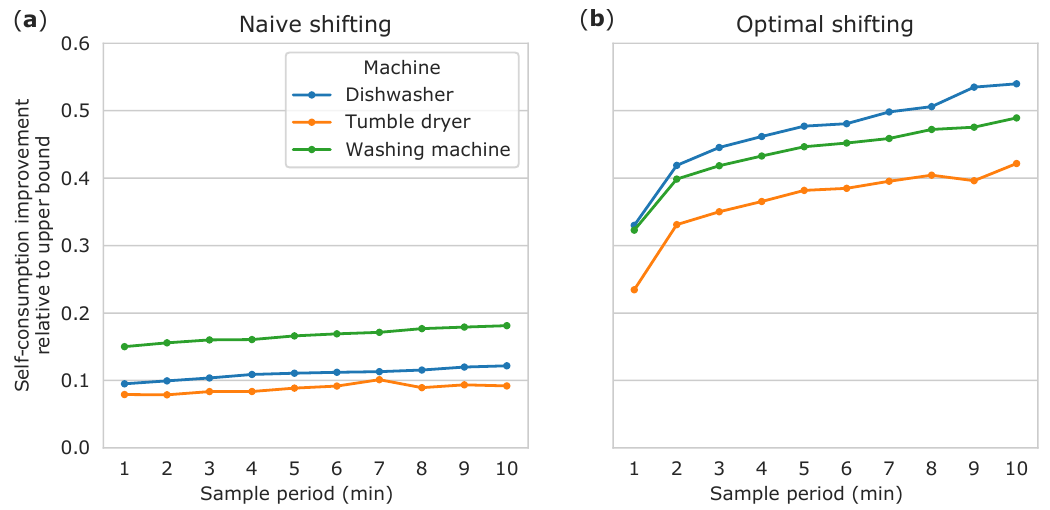
Figure 6. Mean improvement from load shifting grouped by machine type: ( a ) Naive shifting; ( b ) Optimal